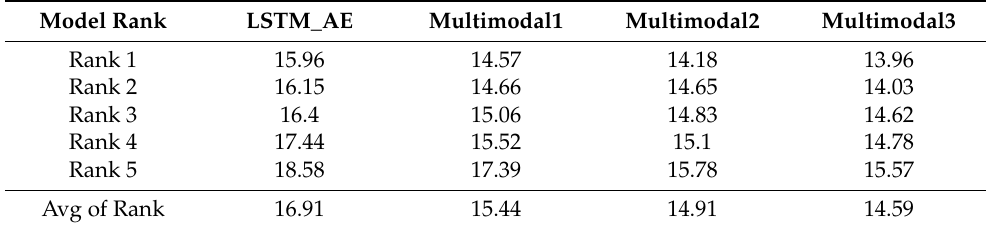
Table 2. Comparison of the performance of proposed models using the original image (Test